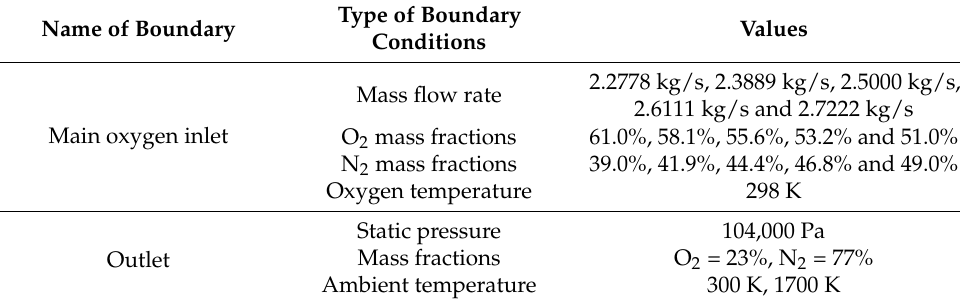
Figure 2. A schematic representation of the mesh model with boundary conditions. In the initial state, there is no combination gas blowing through the nozzles into the computational domain, such that it is filled with stationary air. An axis boundary condition (modena line) is applied to the computational domain. The mass flow inlet boundary condition (blue line) is chosen at the Laval nozzle inlet for the incoming combination gas. The wall model boundary condition (gray line) is adopted at the oxygen lance wall. A pressure outlet boundary condition (red line) is utilized for other computational domain boundaries. Table 2 shows detailed information on the boundary conditions. Table 2. The detailed information of the boundary conditions .